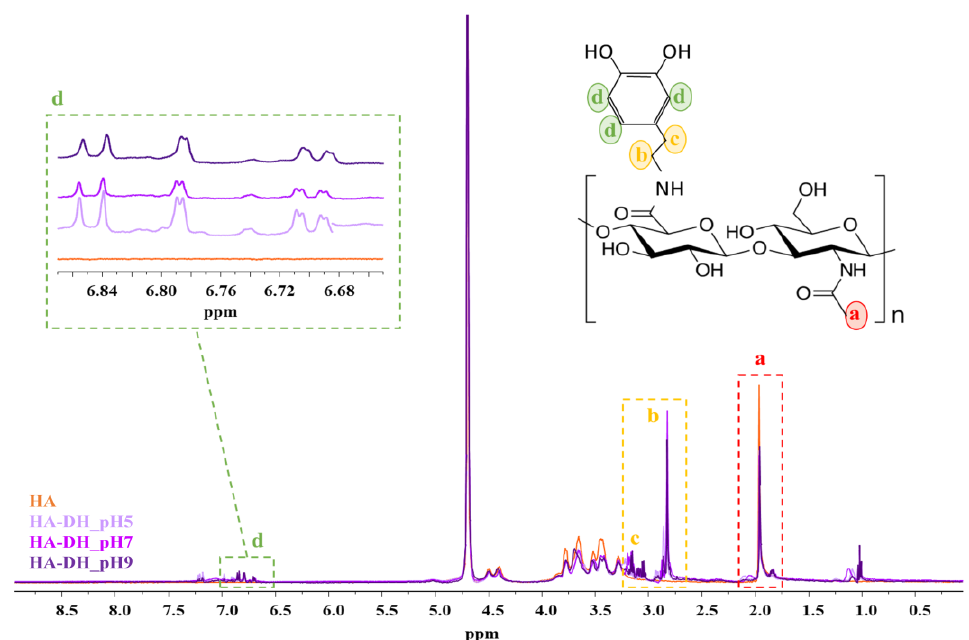
Figure 4. 1 H NMR spectra of HA (orange), HA-DH_pH5 (light violet), HA-DH_pH7 (violet) and HA-DH_pH9 (dark violet). Magnification in the 6.65–6.85 ppm interval highlights the appearance of the peaks ascribed to the hydrogens involved in the aromatic ring. Table 1. Units of DH molecules per g of polymer measured from UV-vis and 1 H NMR spectroscopic analyses performed on HA-DH_pHX samples. Percentages of DH molecules grafted to the HA backbone in the oxidized and unoxidized form.